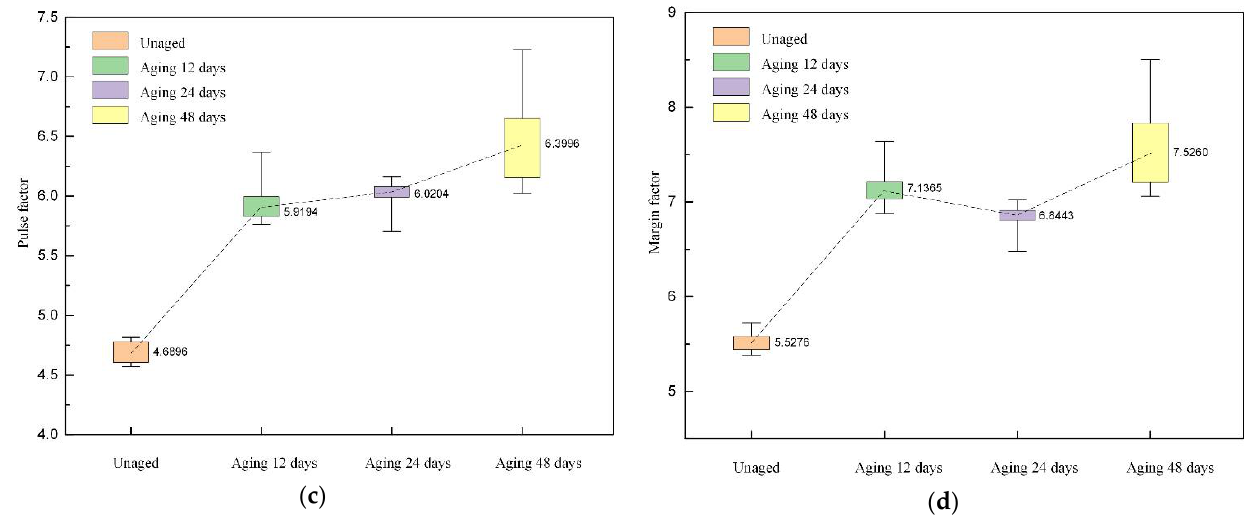
Figure 10. The distribution of dimensionless parameters in the time domain. ( a ) Waveform factor; ( b ) crest factor; ( c ) pulse factor; ( d ) margin factor.